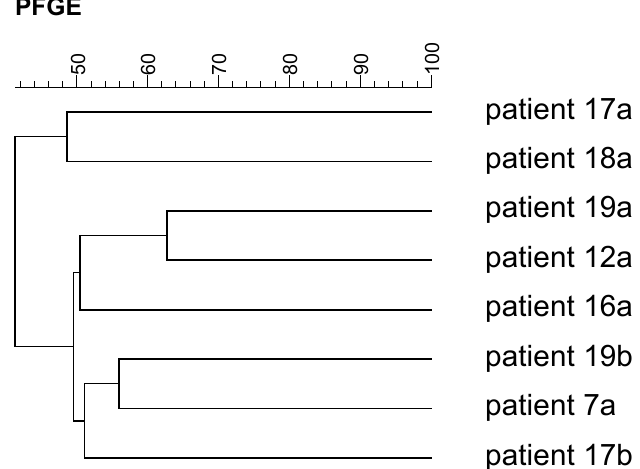
Figure 3. Dendrogram of Escherichia coli isolates from the respiratory tract. Horizontal axis— similarity of bacterial isolates (%). Vertical axis—isolate number; letter a denotes isolates from endotracheal secretion and letter b denotes isolates from the upper respiratory tract.